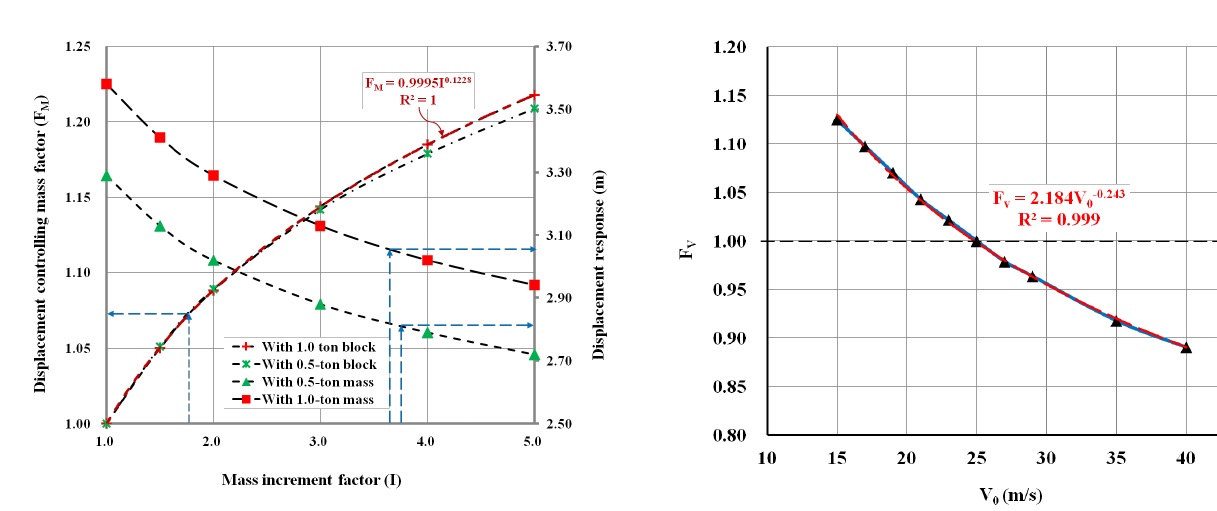
Figure 7. The “displacement response velocity factors“ for the R-LPR structure at 150 kJ. 2 Fig. 7. The “Displacement response velocity factors” for the R-LPR structure at